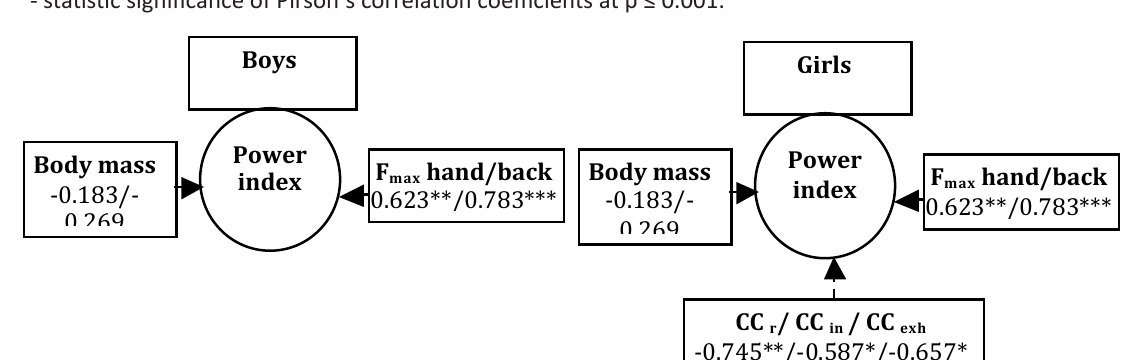
Fig. 5. Interconnection of power index with somatologic indicators of students – members of biathlon sport-pedagogic perfection group. CC - chest circumference in rest; CC r at exhale; indicators, which compose index; indicators, which influence on